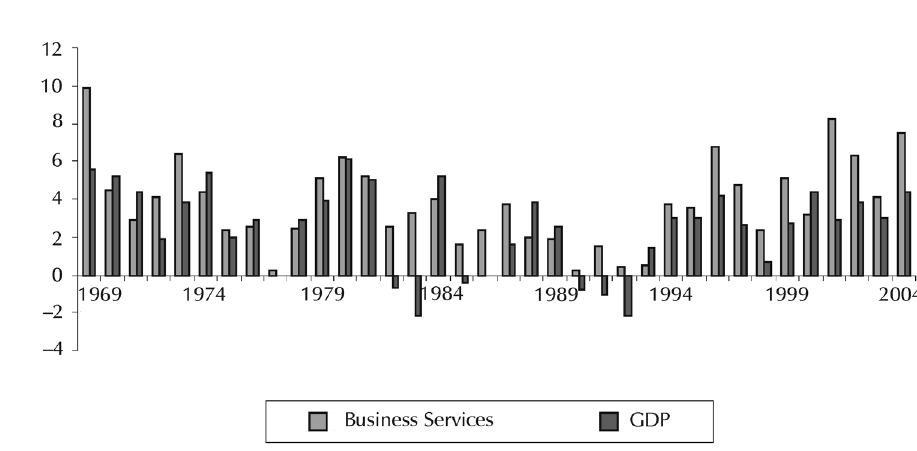
GDP and business services growth performance (per cent),